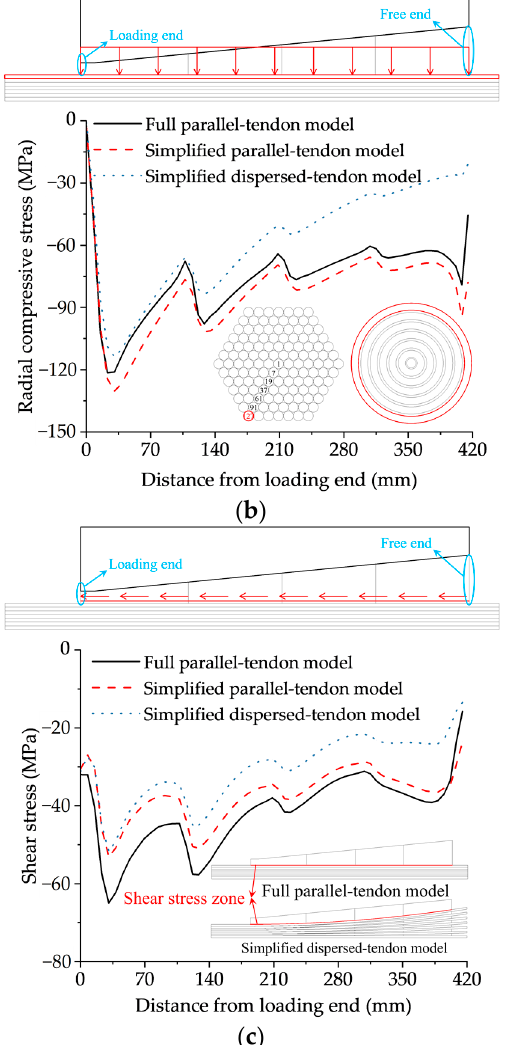
Figure 9. Simulated results of three FE models: ( a ) axial tensile stress of T-1, ( b ) radial compressive stress of T-127, and ( c ) shear stress of the LTC.